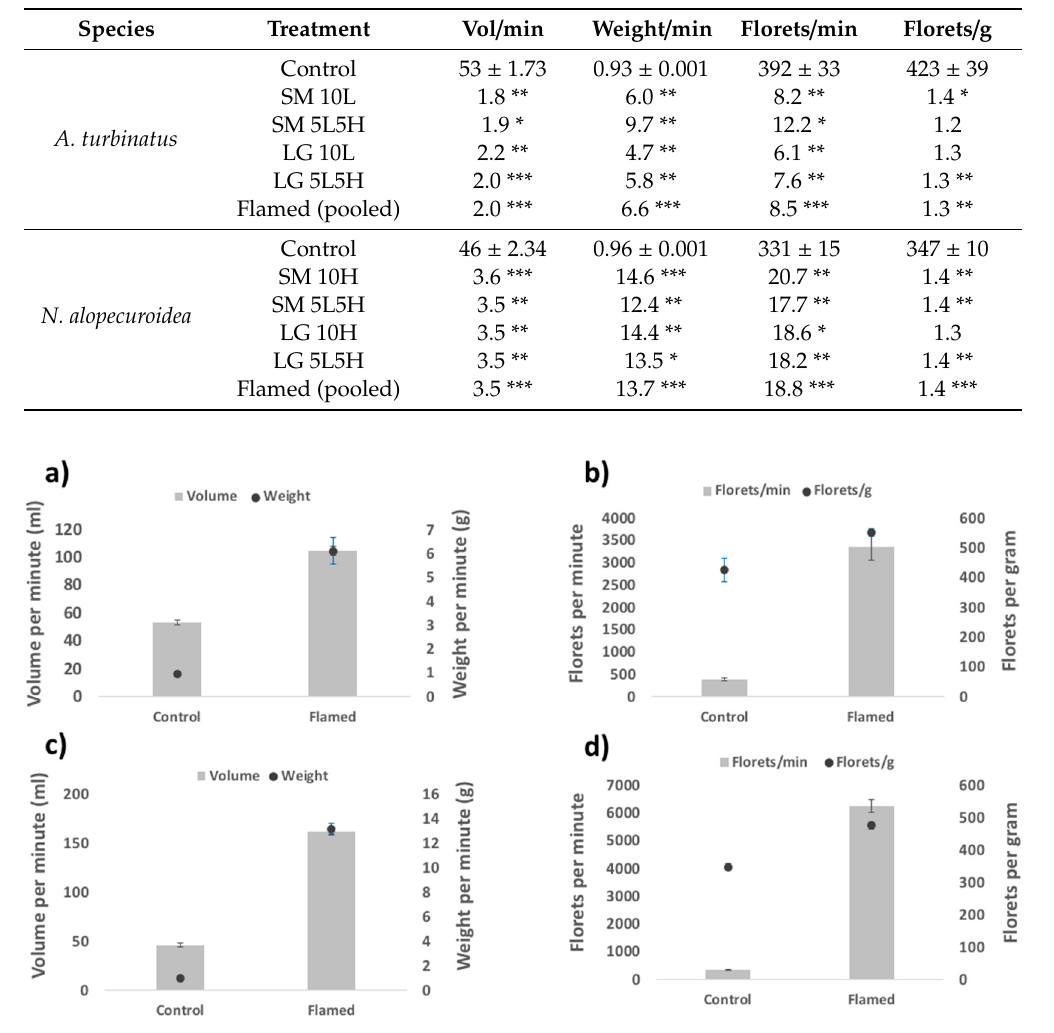
Figure 2. Mean values for flowability properties volume, weight, and florets passed per minute, and the number of florets per gram for Amphipogon turbinatus and Neurchne alopecuroidea (panels a , b and c , d , respectively). Comparisons are displayed for treatment groups control and flamed. Differences in flowability properties between the different flaming treatments were generally insignificant (Table S7), thus flaming data were pooled for the purposes of graphical representation (pooled values are provided in Table S6). Error bars represent standard error of the mean.